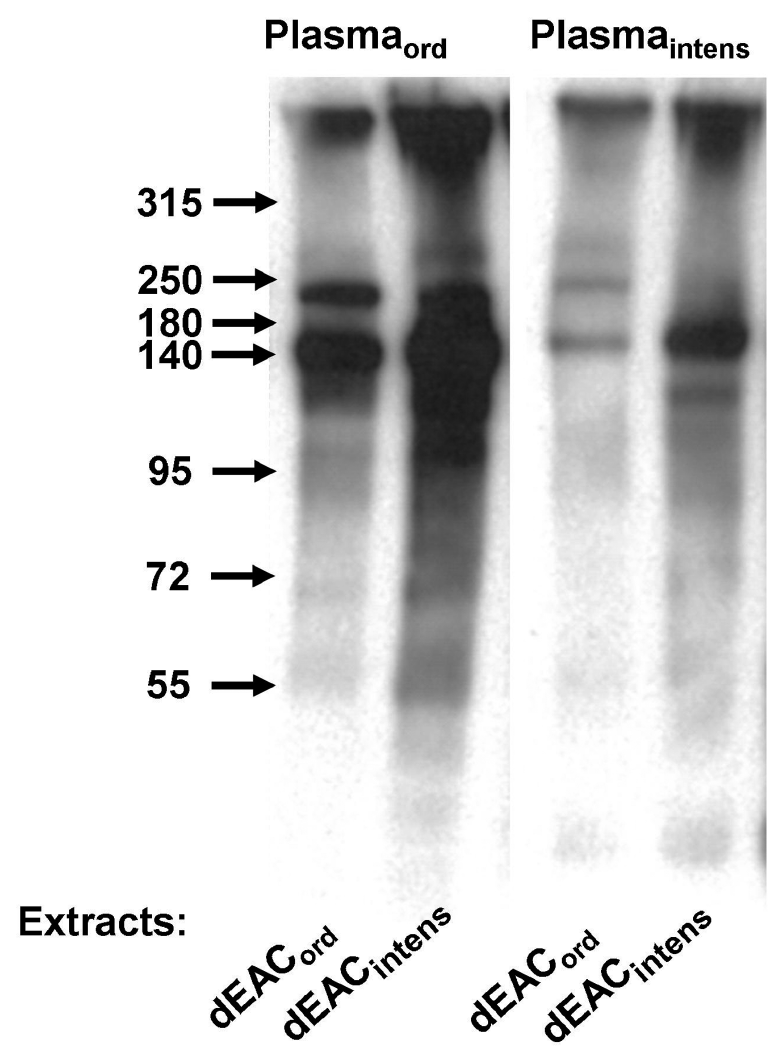
Figure 4. Detection of specific antibodies in mouse plasma after immunization with dEAC ord (plasma ord ) and dEAC intens (plasma intens ). NMRI mice were injected with aqueous extracts of dEAC ord or dEAC intens over 17 days and plasma was probed as a primary antibody on 30 m g of extracts of dEAC ord and dEAC intens seperated by SDS-PAGE and transferred to PVDF membrane. Bound antibodies were visualized with anti-mouse peroxidase-labeled secondary antibodies and the enhanced chemiluminescence system. A typical blot of three independent similar experiments is